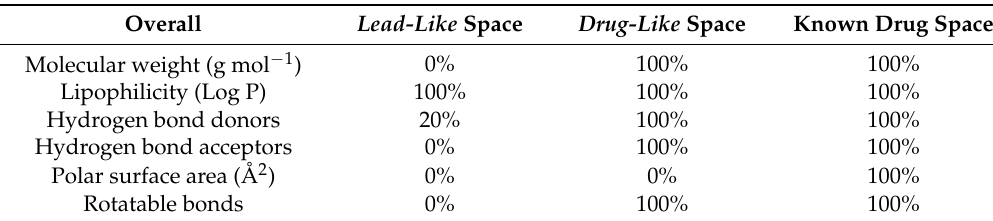
Table 5. Flavonolignans studied within the defined chemical spaces.